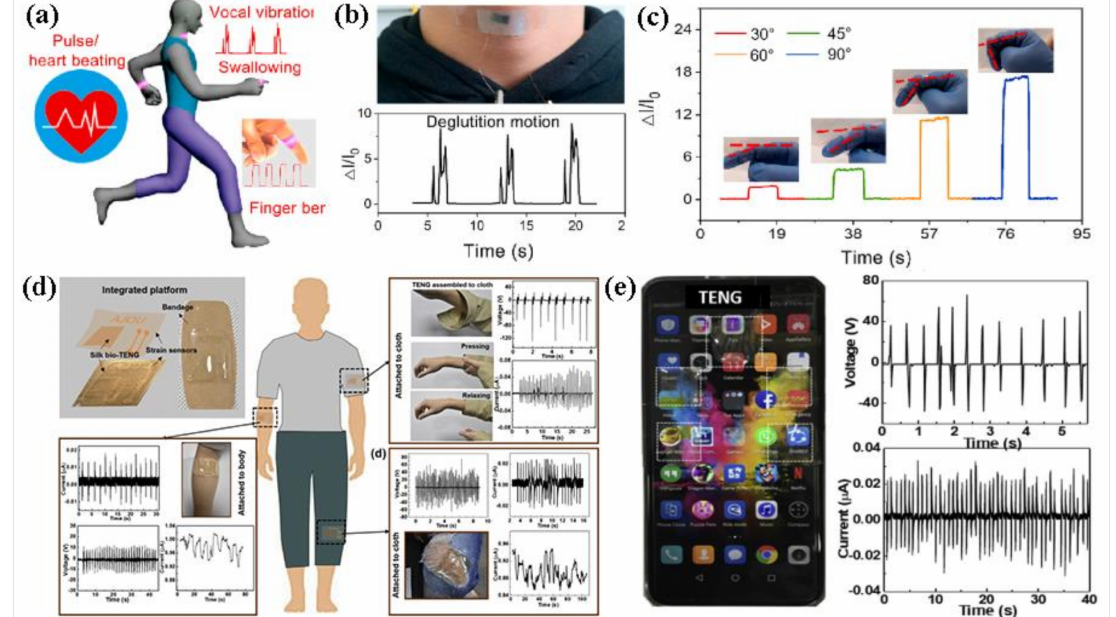
Figure 6. ( a ) Overview of sensing applications of the SF/Mxene flexible sensor for the detection of various physiological human motions, ( b ) Photograph of the SF/Mxene flexible sensor attached onto the throat and response signals of deglutition motion, ( c ) the response of SF/Mxene flexible sensor in monitoring finger bending under different angles. Reproduced with permission from [63]. Copyright 2020, Elsevier; ( d ) schematic diagram and photograph images of the integrated strain sensor and the bio-TENG on a bandage, and the applications of the integrated devices to measure various human motions, ( e ) photograph images and outputs of the bio-TENG devices attached to a cell phone. Reproduced with permission from [64]. Copyright 2019,